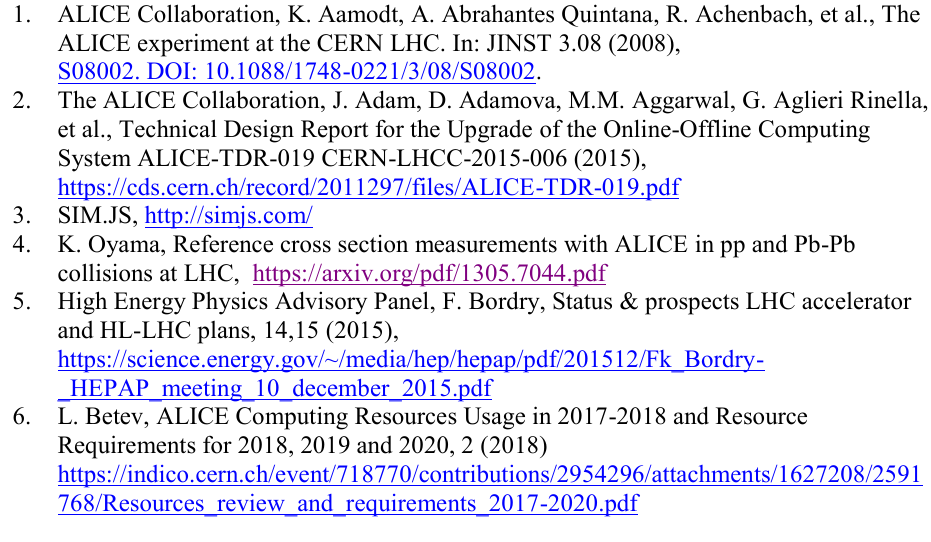
Table 4. The total amount of data created during the 1st year of Run